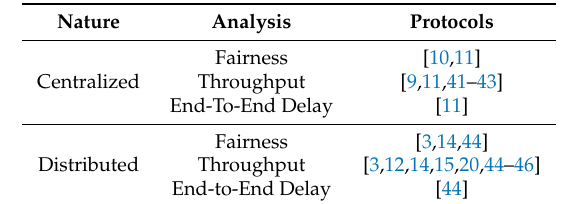
Table 2. Category of Full Duplex MAC